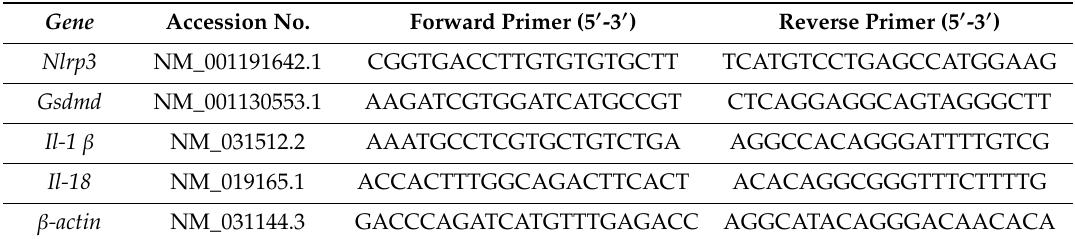
Table 1. The primer sequences used for qPCR